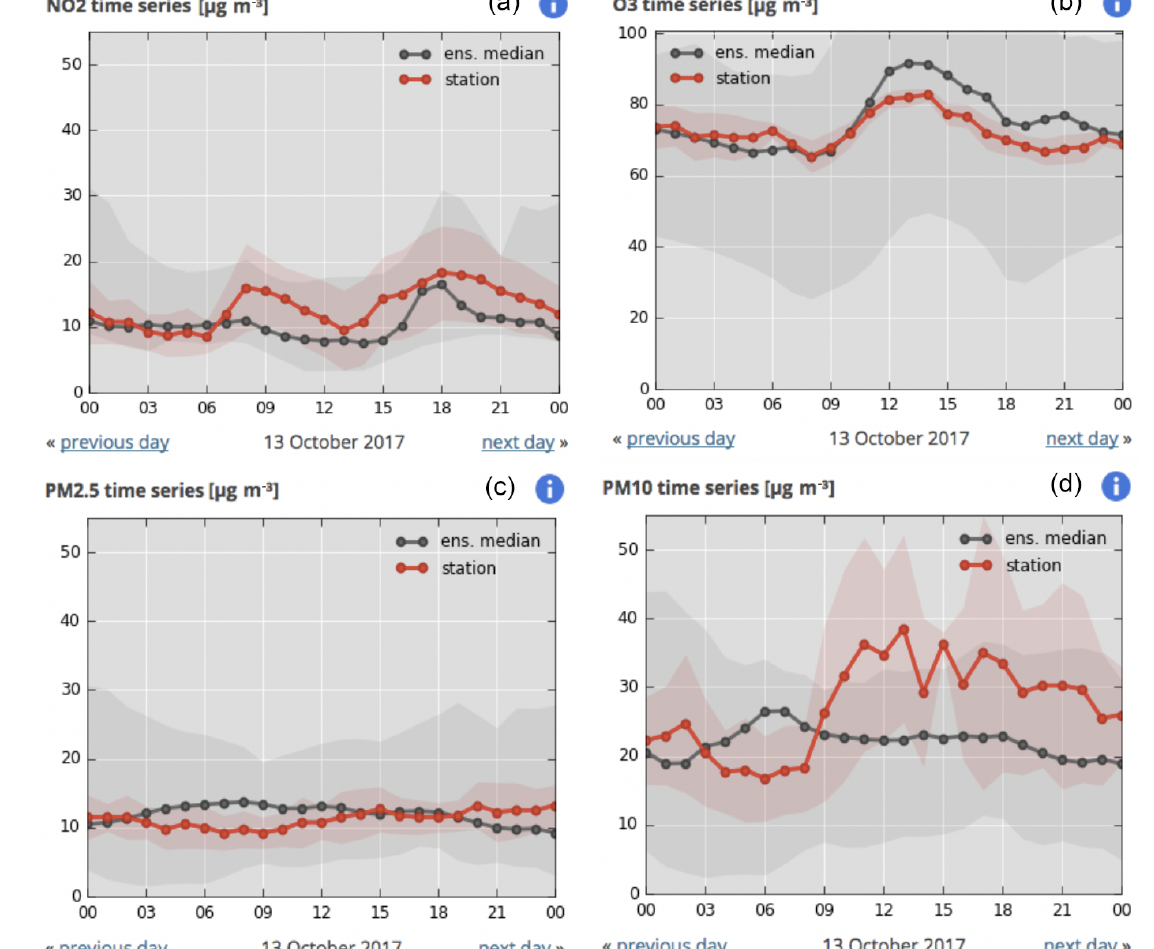
Figure 3. Median concentrations of NO 2 (a) , ozone (b) , PM 2 . 5 (c) , and PM 10 (d) predicted for the city of Xiamen on 13 October 2017 (black curve) and compared with the measured values (red curves). The dispersion of the forecasts by the individual models belonging to the ensemble is shown by the grey range, and the dispersion of the measured values at different stations in the city are depicted by the pink